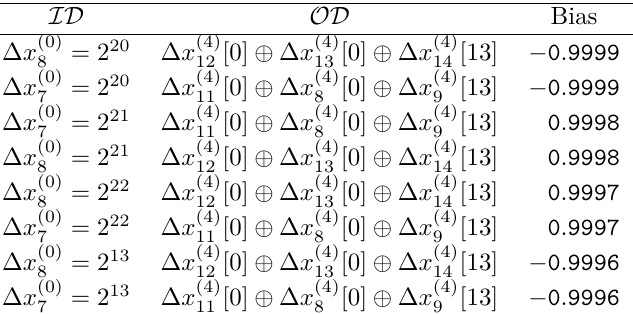
Table 8: Best triple bit differentials for 4 rounds of Salsa